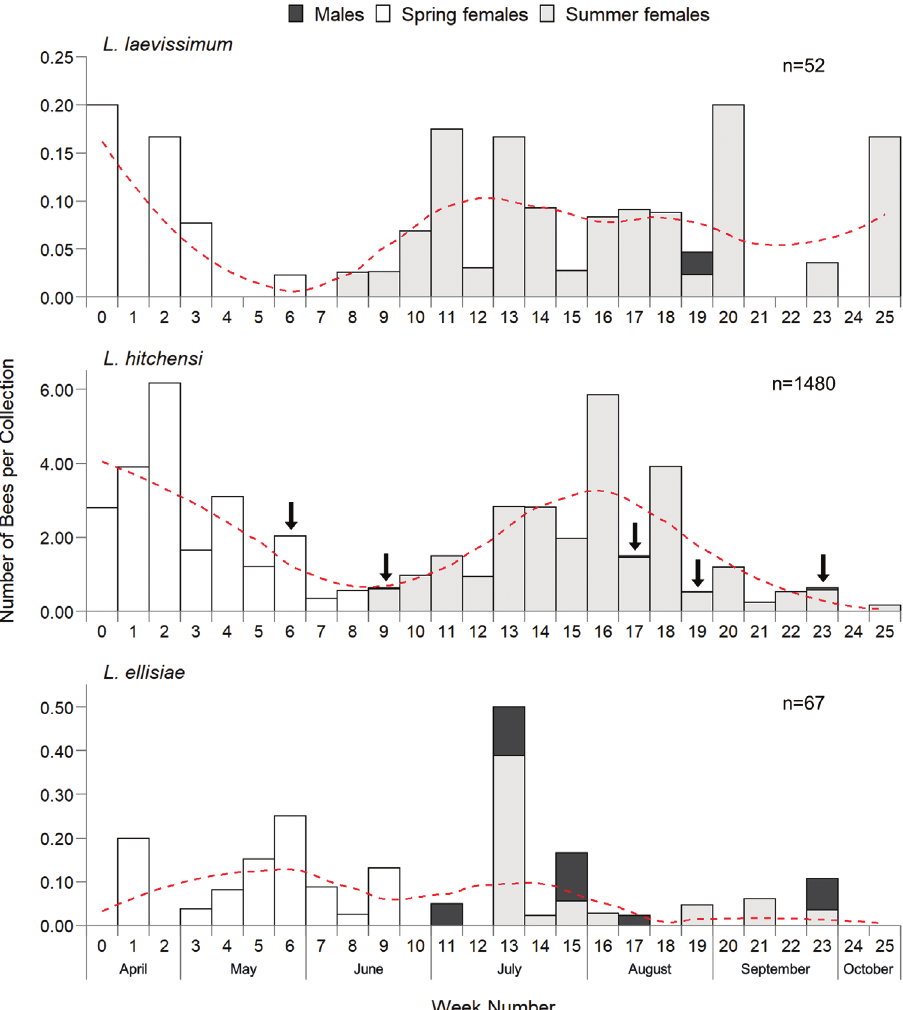
Figure 1. Bivoltine flight phenologies of L. laevissimum , L. hitchensi and L. ellisiae , inferred from pan trap collections, 2003–2013. The number of bees collected per week represents the average number of bees collected in pan traps, across sites and years, from 2003 to 2013. A total of 52 L. laevissimum bees, 1480 L. hitchensi bees, and 67 L. ellisiae bees were collected. Dark grey bars represent males, white bars represent spring females and light grey bars represent summer females. The red polynomial regression (drawn using the geom_smooth function, Loess method, in R) was used to help visually identify the number of abundance peaks for each species. Black arrows indicate the weeks when L. hitchensi males were collected in pan